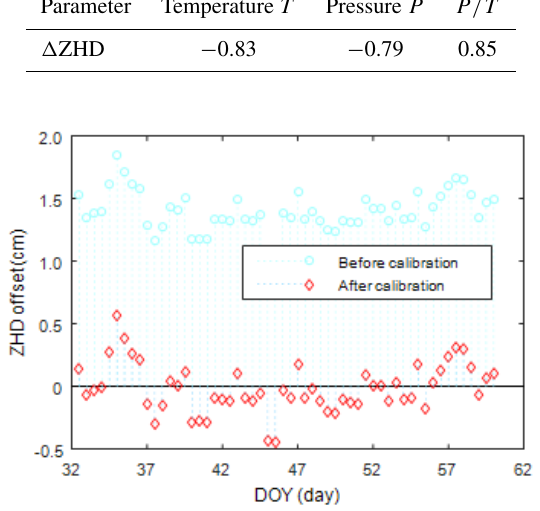
Figure 2. ZHD offsets before and after calibrations with respect to radiosonde-derived ZHD using datasets in Hong Kong in February